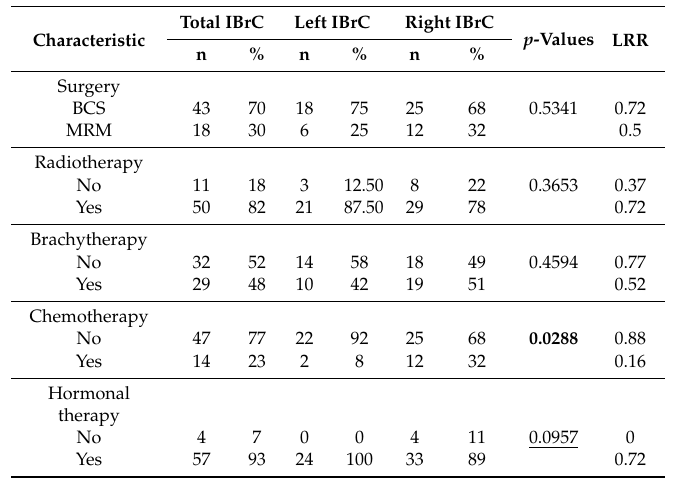
Table 3. Laterality of luminal A breast cancer patients and their treatment